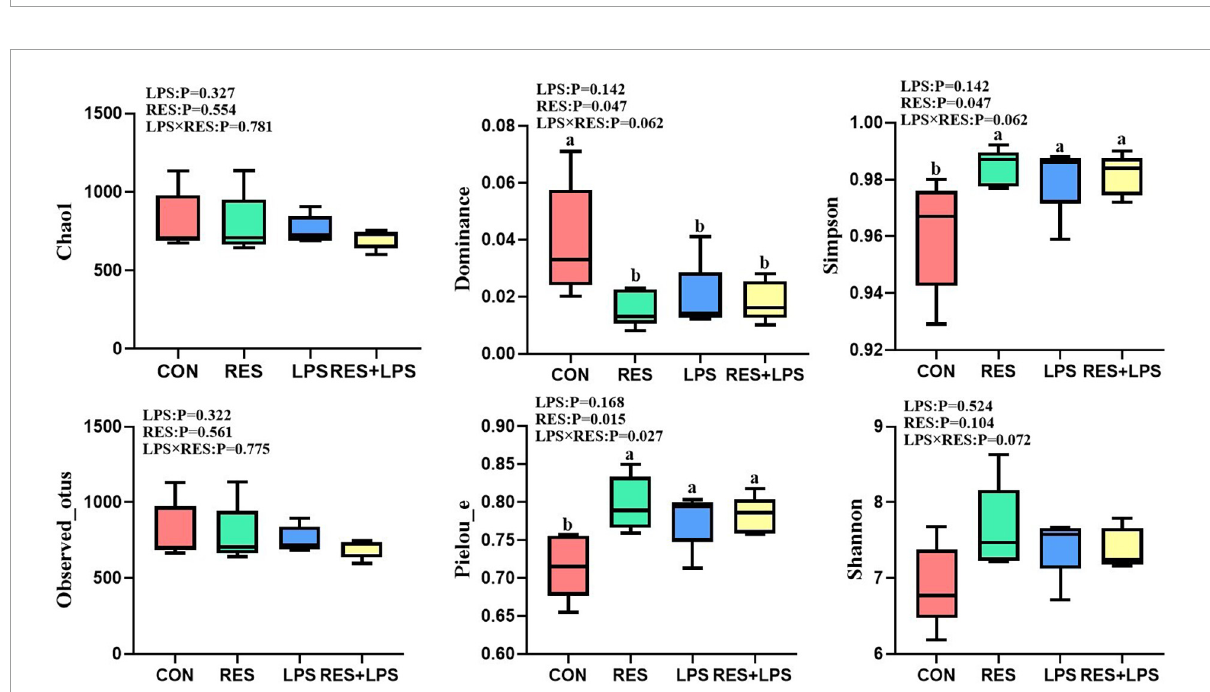
FIGURE4 The effect of dietary resveratrol supplementation on the alpha diversity of cecal microbiota in yellow-feathered broilers. ab Means in the columns with different superscripts differ ( P < 0.05). CON, control; RES, resveratrol; LPS, lipopolysaccharide; RES + LPS, dietary resveratrol treatment followed by LPS